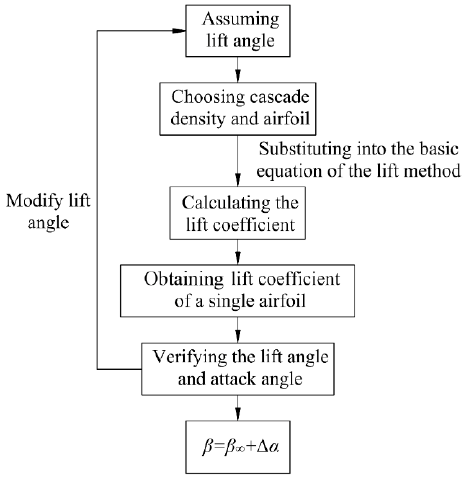
Figure 23. The flowchart of design by lifting design method.